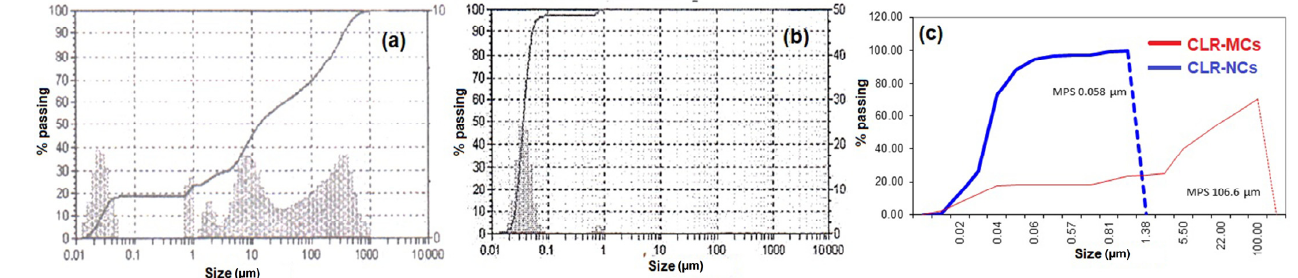
Figure 3. PS of ( a ) CRL-MCs, ( b ) CRL-NCs (gray area indicates the PS distribution), and ( c ) comparative graphical representation of both CRL-MC and -NCs.